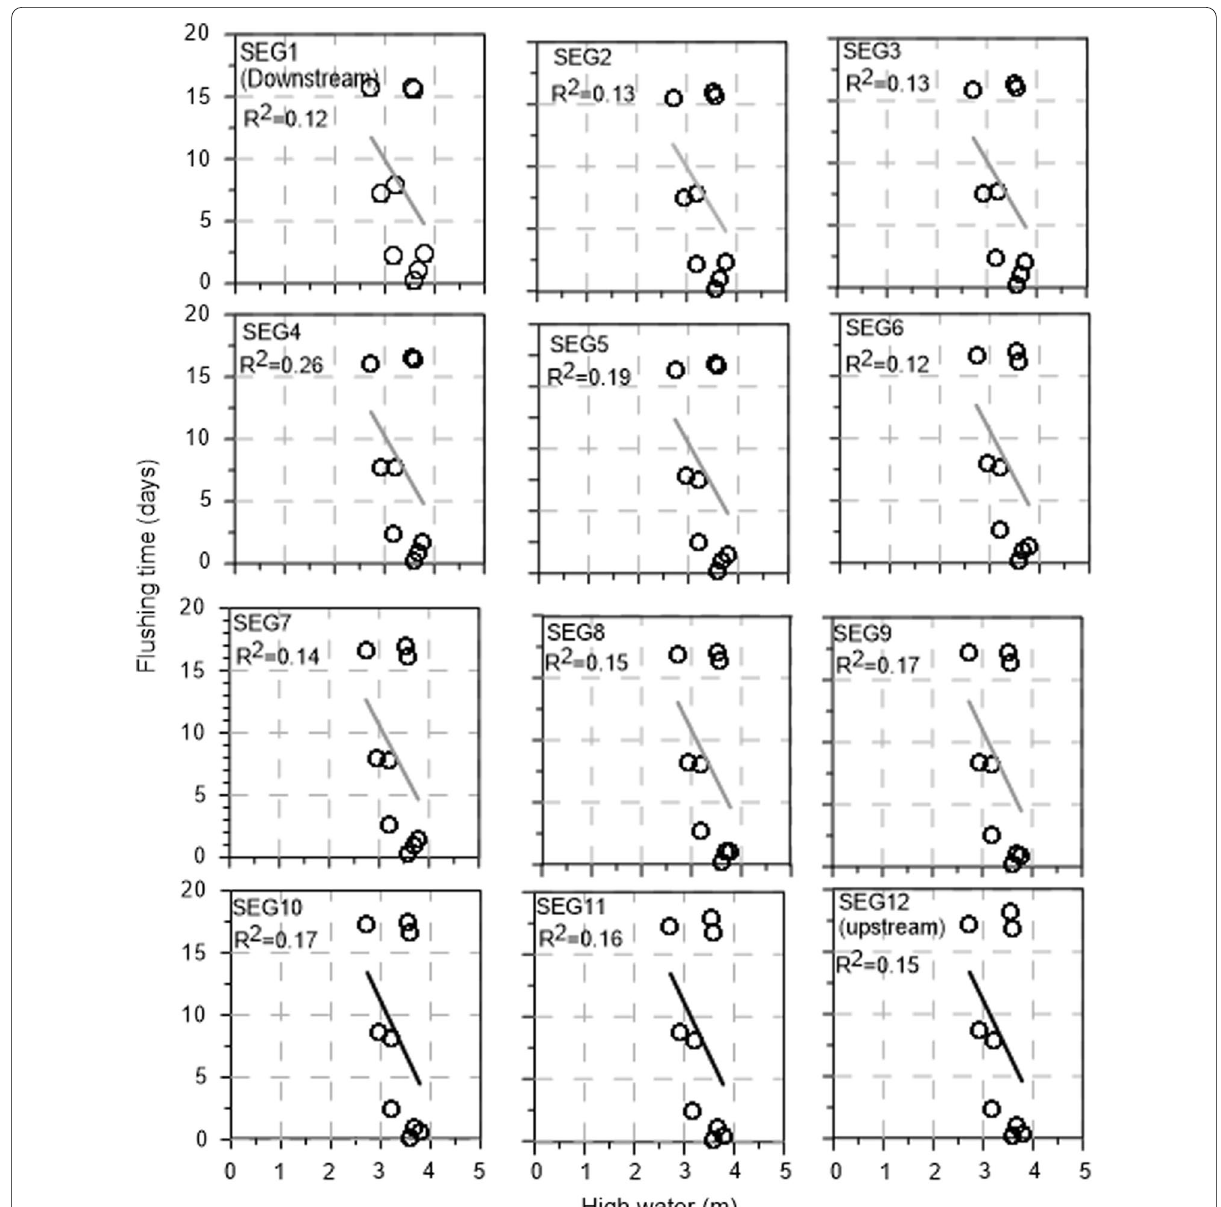
Fig. 10 Comparison of the power‑law relations between e‑folding flushing time (days) and high‑water level (m) for multiple estuarine